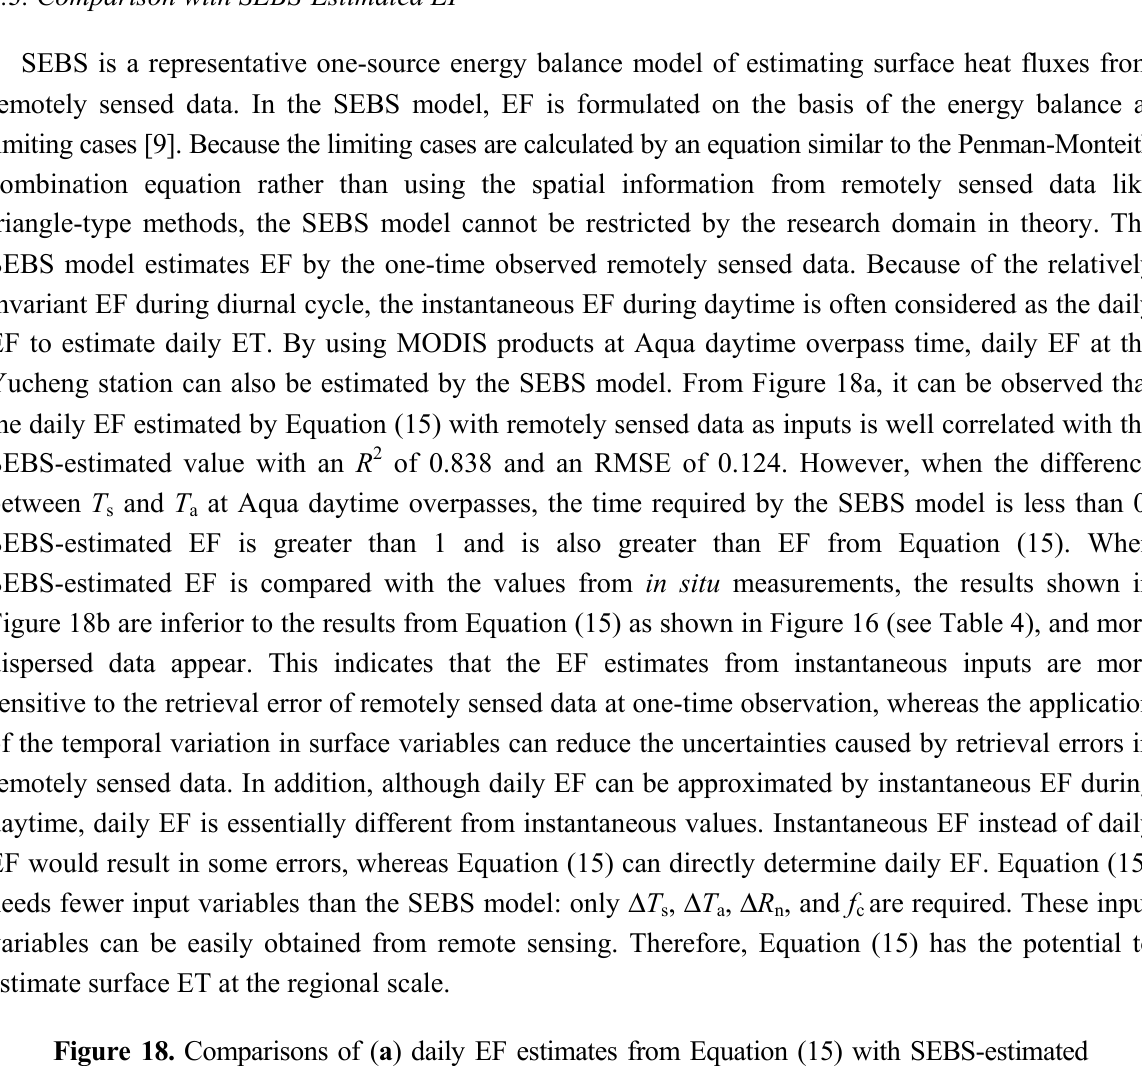
Figure 18. Comparisons of ( a ) daily EF estimates from Equation (15) with